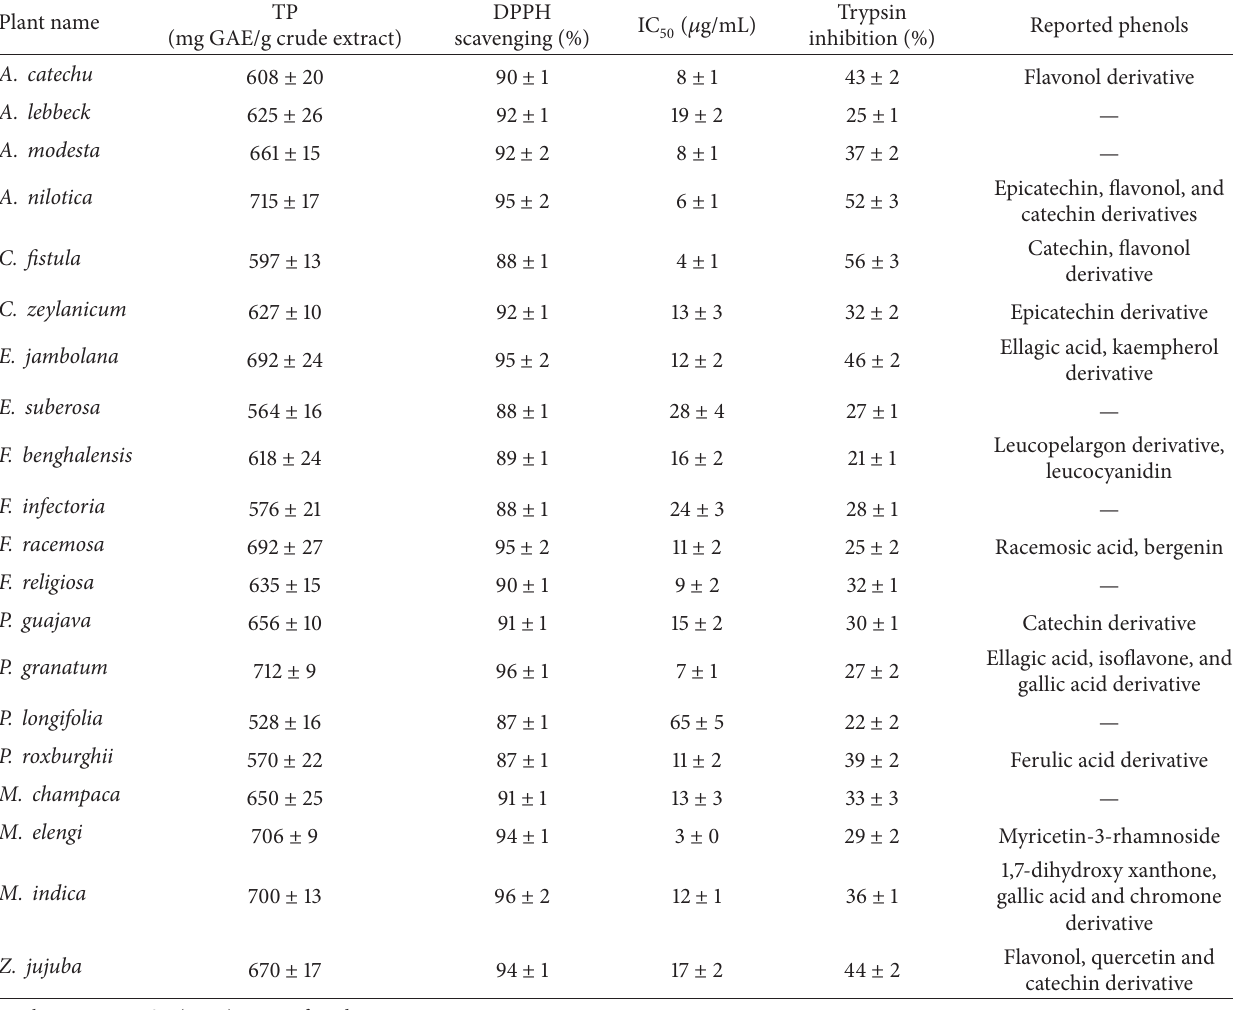
value of medicinal plants. 50